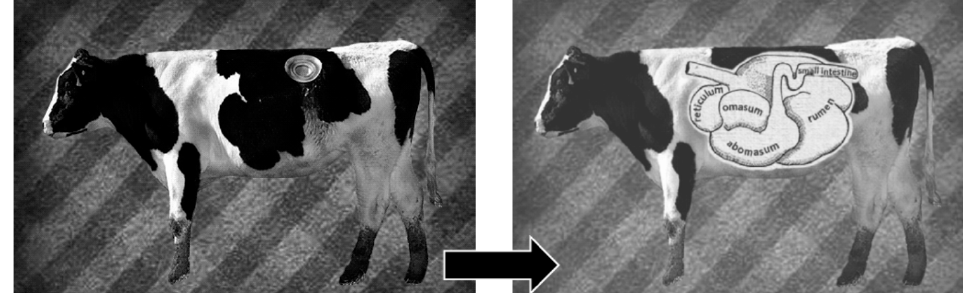
Figure 1. Cannulated cow and the anatomical site where the cannula is located (from University of California Research– How a permanent hole in a cow’s stomach is beneficial. From: https:// ucresearch.tumblr.com/post/123651056610/the-expression-holy-cow-may-be-quite-appropriate, ac- cessed on 15 April